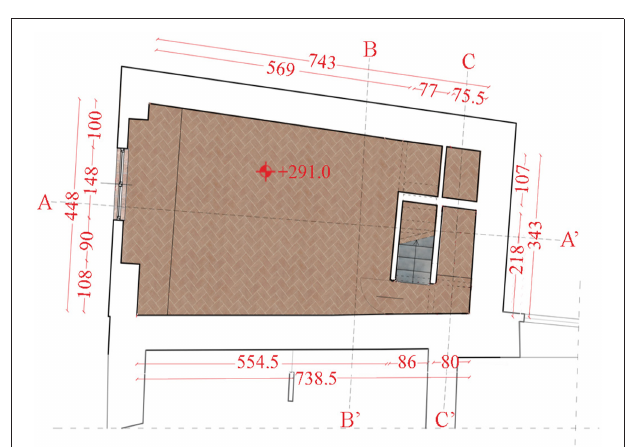
FIGURE 4 | Plan of the first floor of the Lanfreducci Tower.